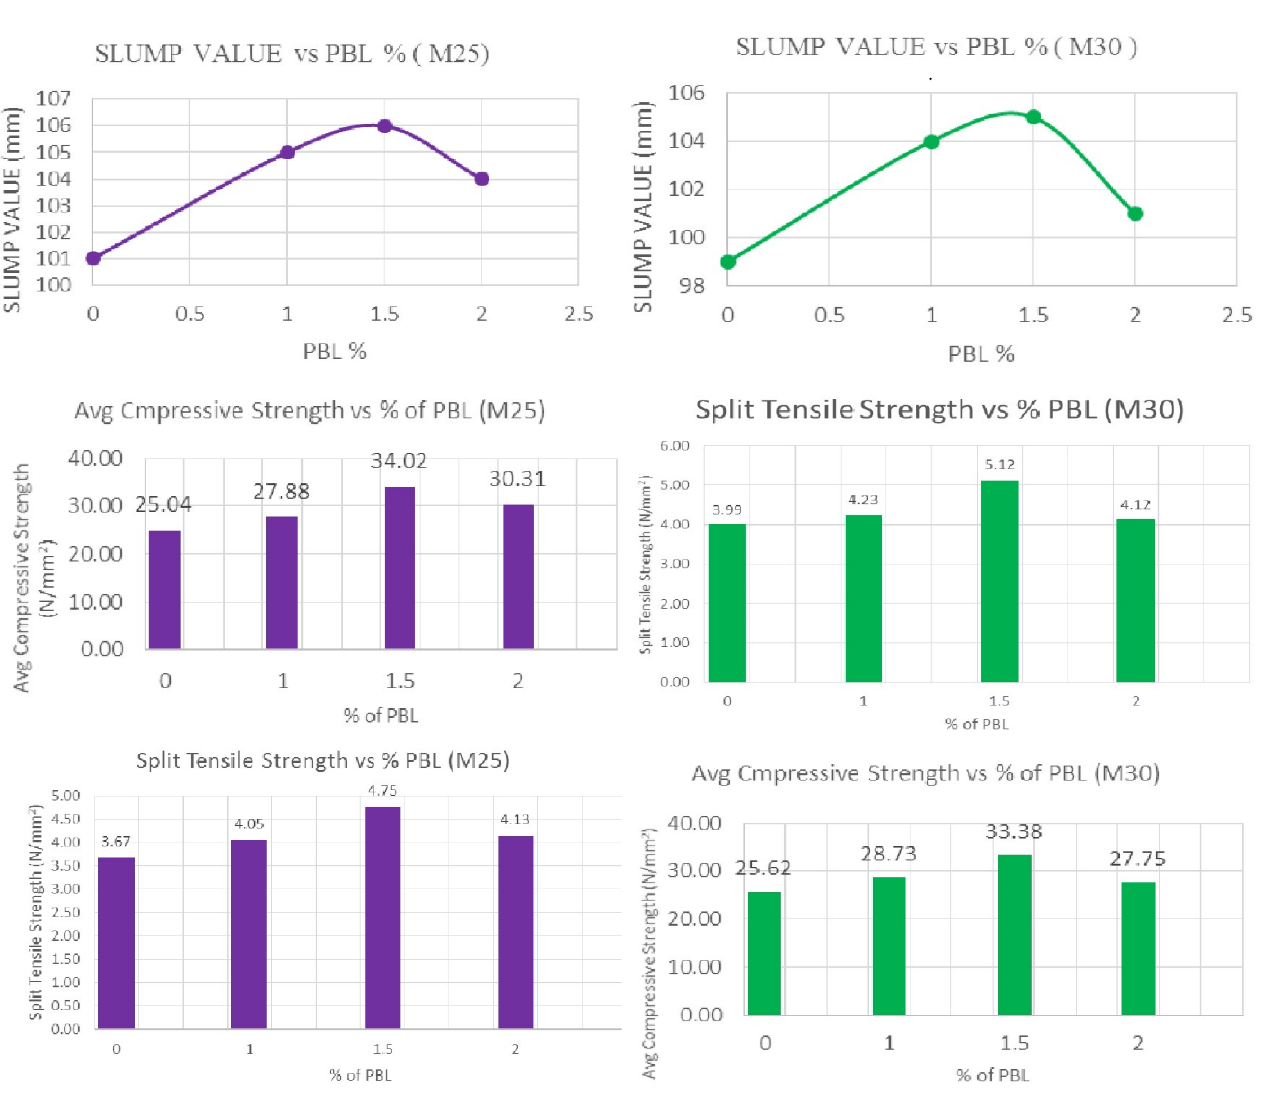
Figure 3. Test results pulp black liquor (PBL) for different grades of concrete